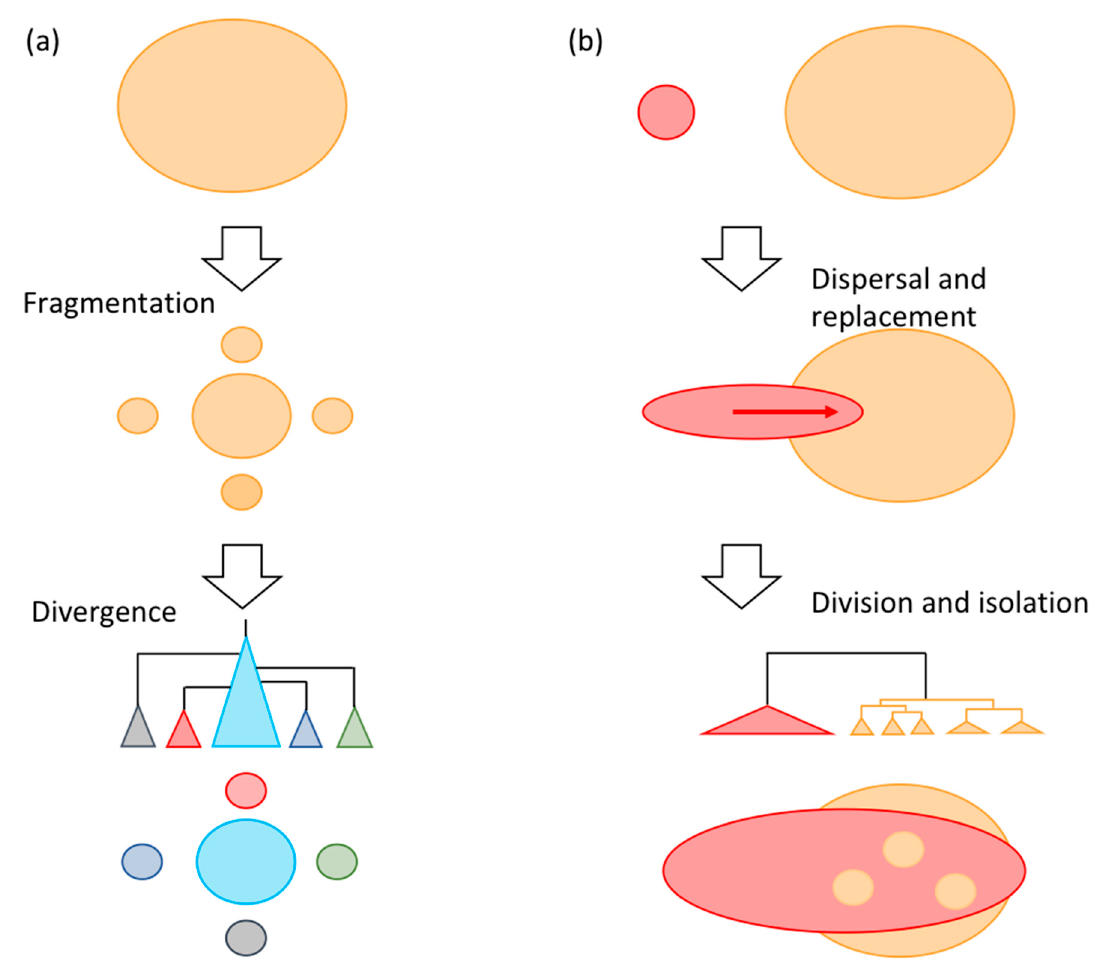
Figure 1. Schematic illustration of conventional fragmentation and replacement. ( a ) Conventional fragmentation, where fragmented populations diverge into small populations with unique genetic features. Isolated populations do not comprise monophyletic groups in the phylogeny but are interspersed by the main population. ( b ) Local populations (three small circles and upper and lower fragments colored by orange) recently divided by competitors from different clades are genetically homogeneous and comprise monophyletic groups.